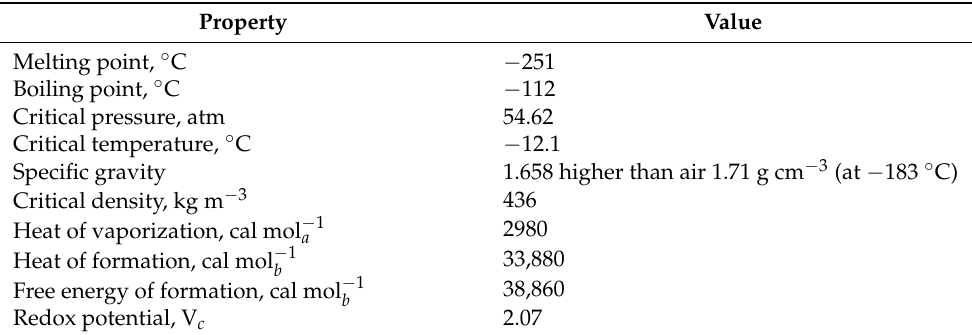
Table 10. Physiochemical properties of ozone. Reproduced from Ref. [89]. Copyright 2020 Elsevier.